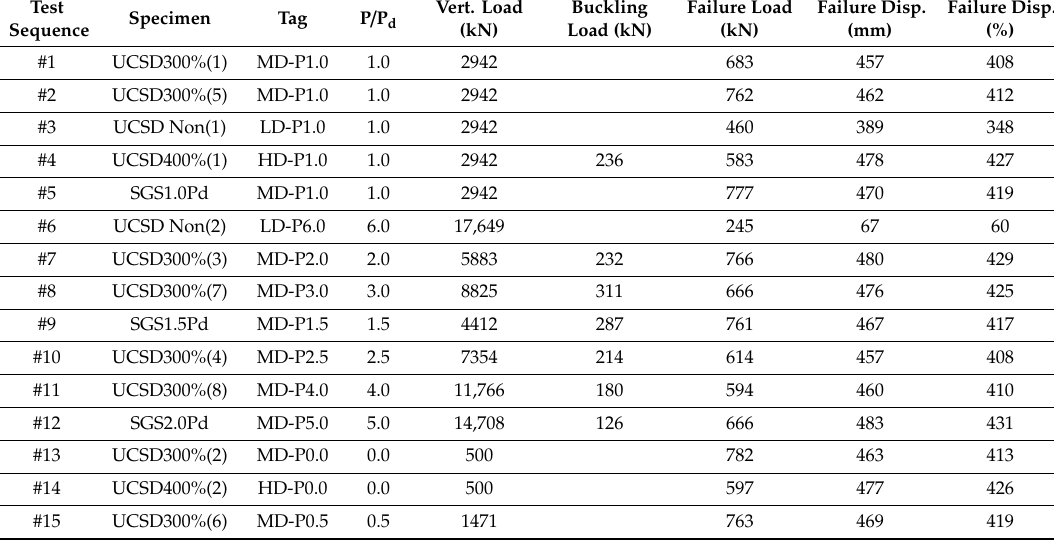
Figure 14. LRB specimen dimensions. Table 4. Specimens for the ultimate property test.